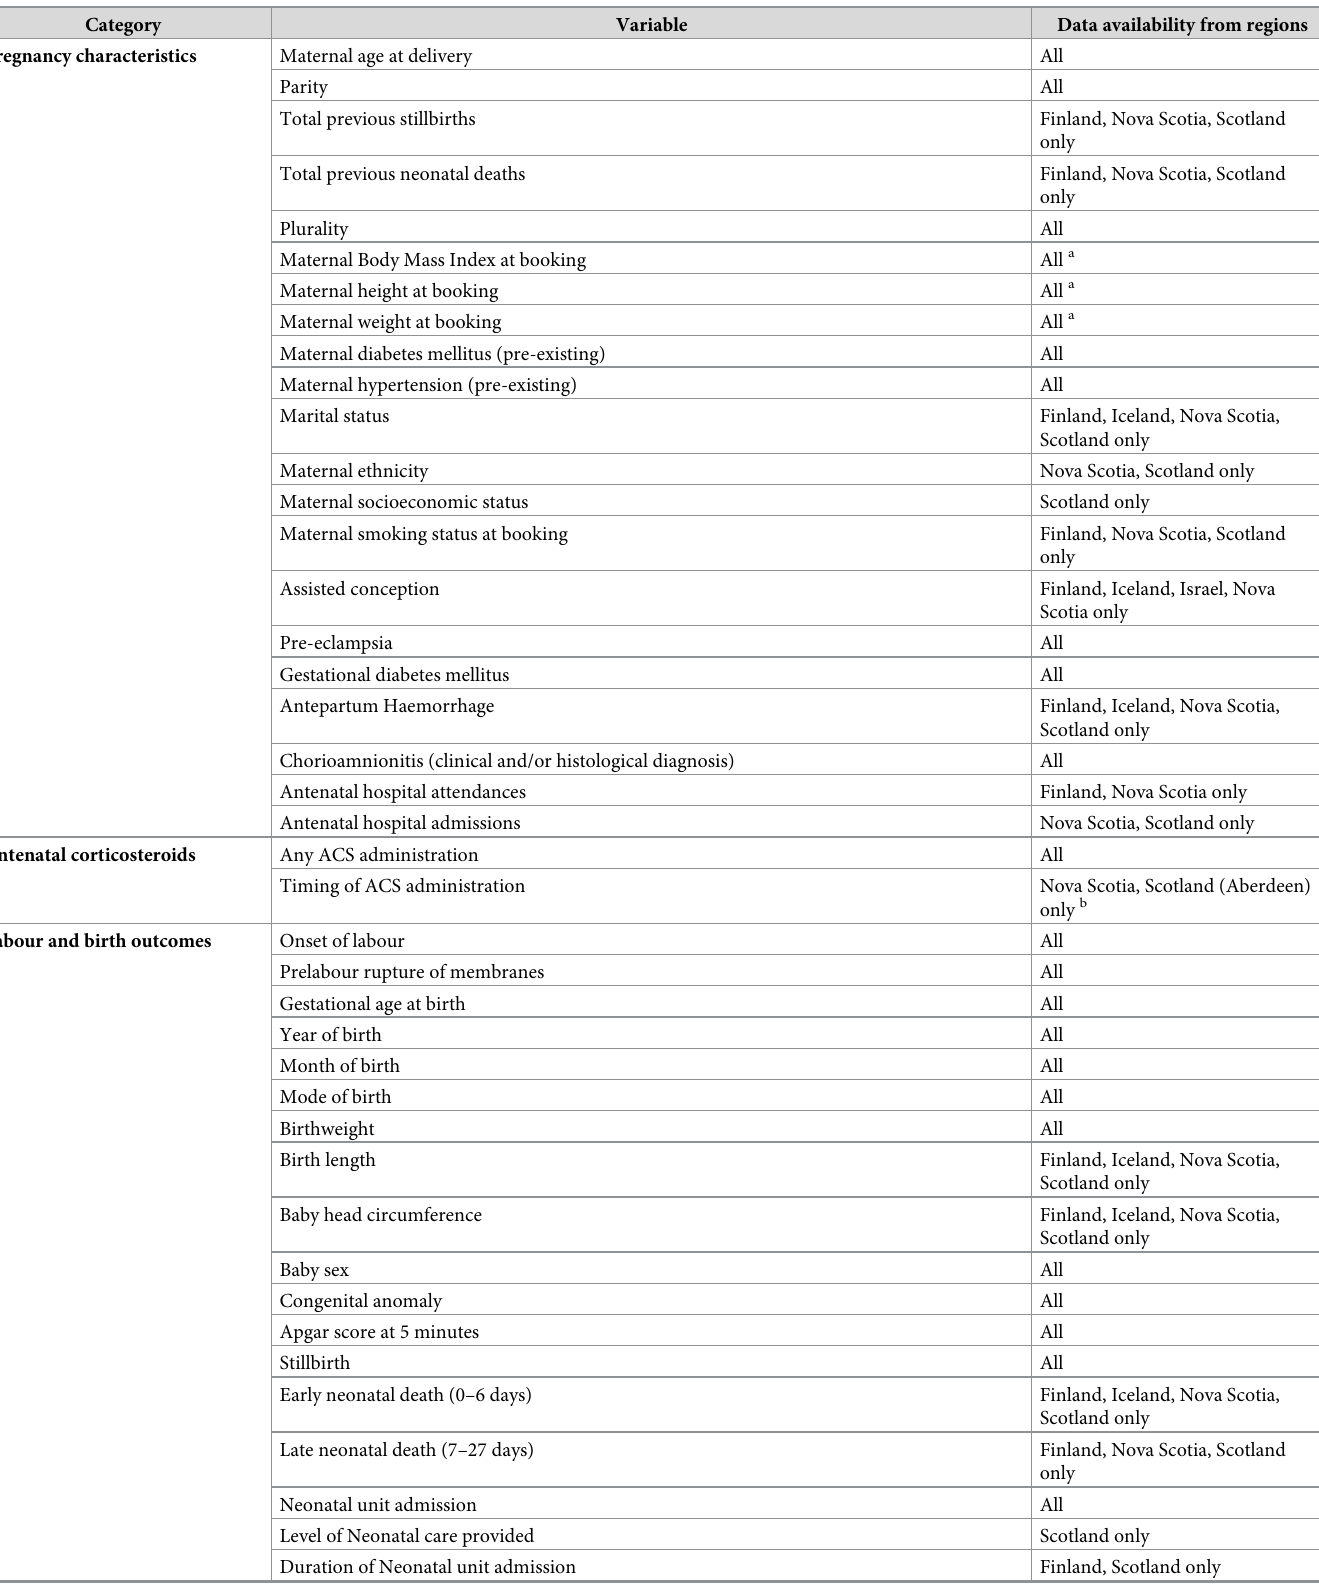
Table 2. Variables in the Co-OPT ACS cohort and data availability from contributing